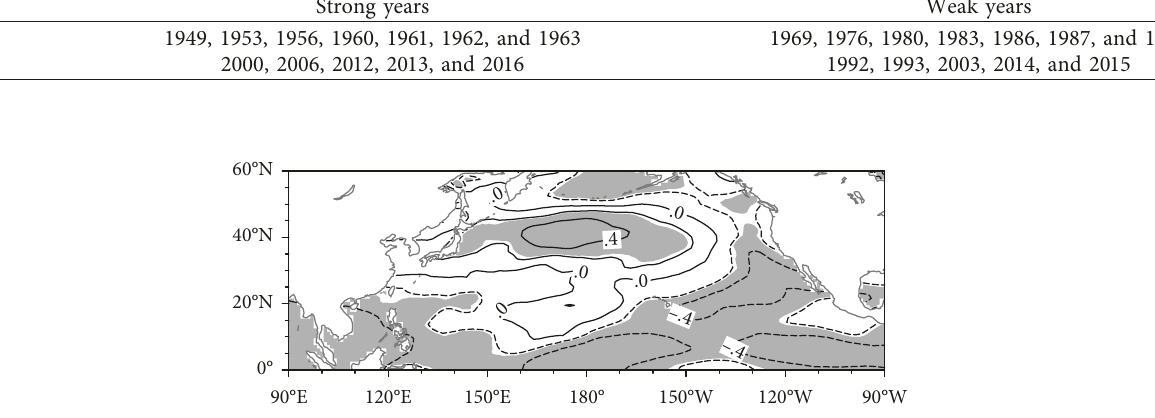
Figure 5: Spatial distribution of the correlation coefficient between the APOI and SST during 1948–2016. The shaded area indicates significant correlation at the 95% confidence level based on Student’s t -test.